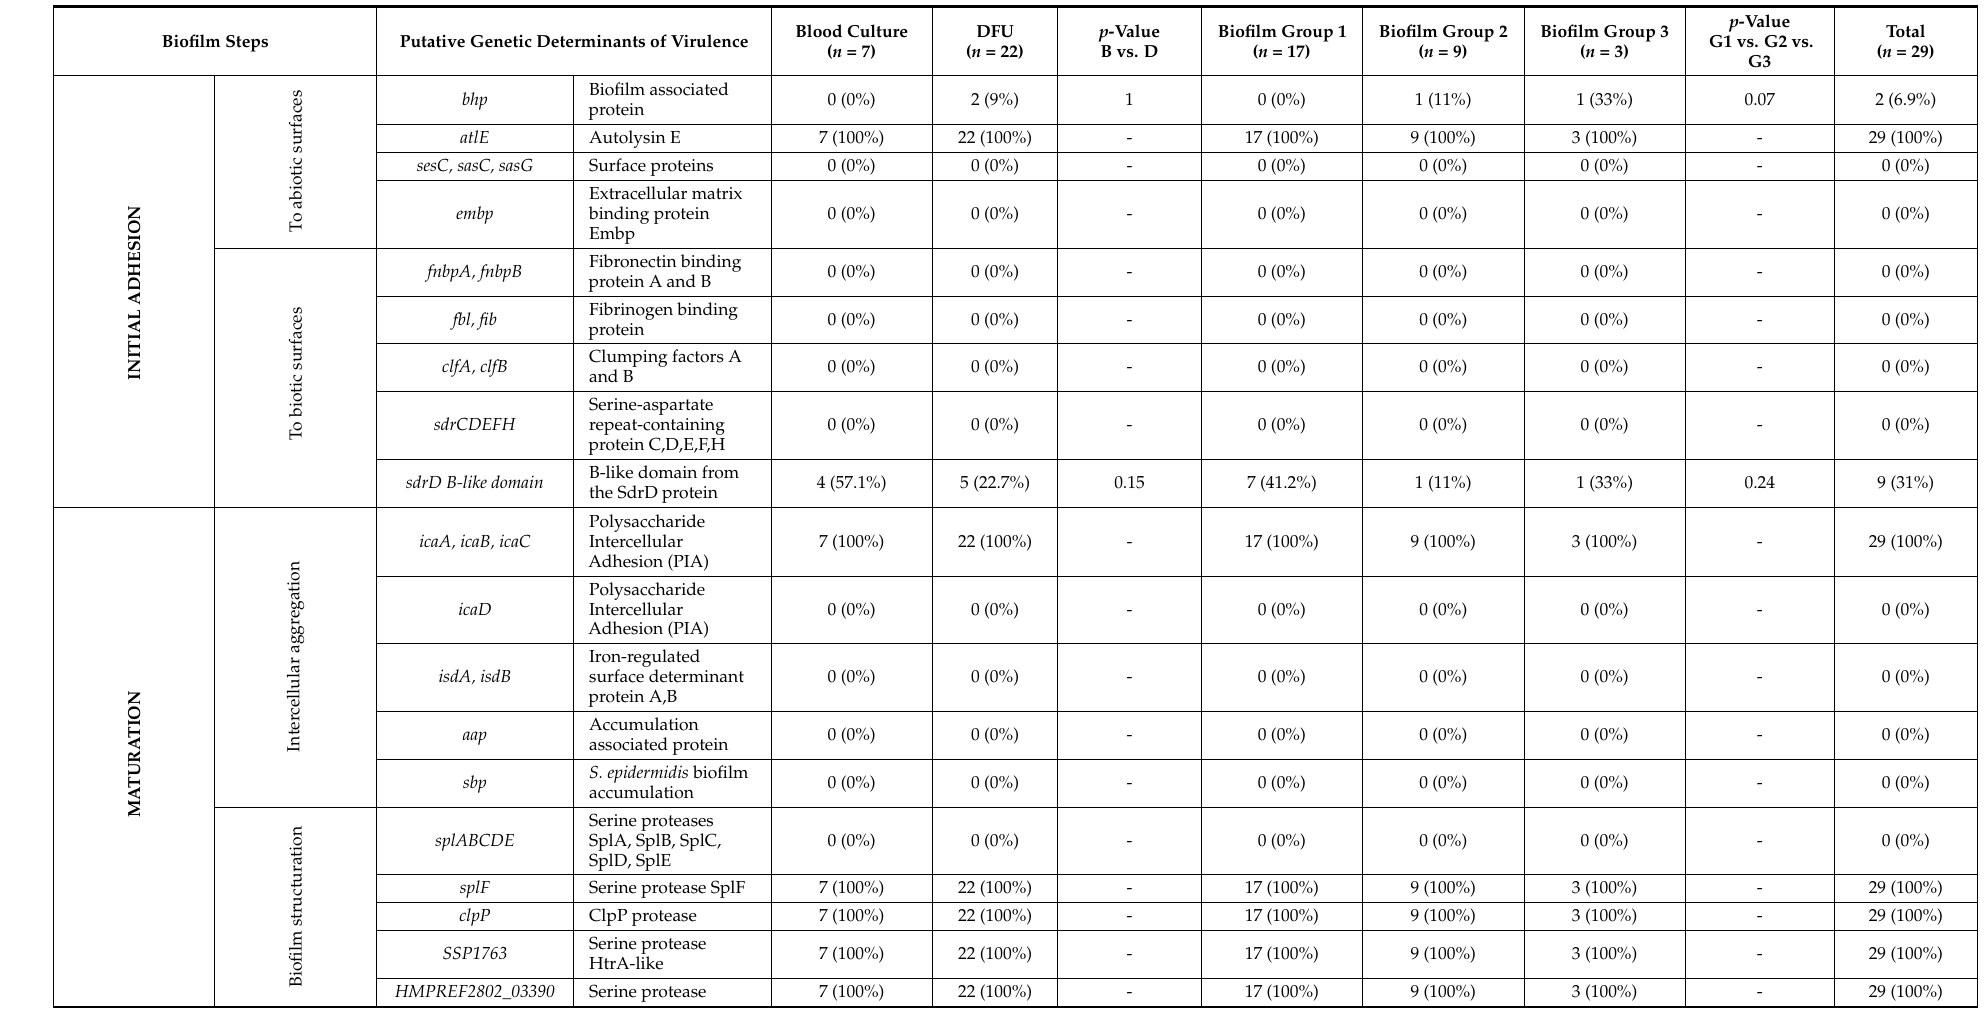
Table 3. Comparison of biofilm-related genes between the S. pettenkoferi blood culture and DFU strains groups and biofilm